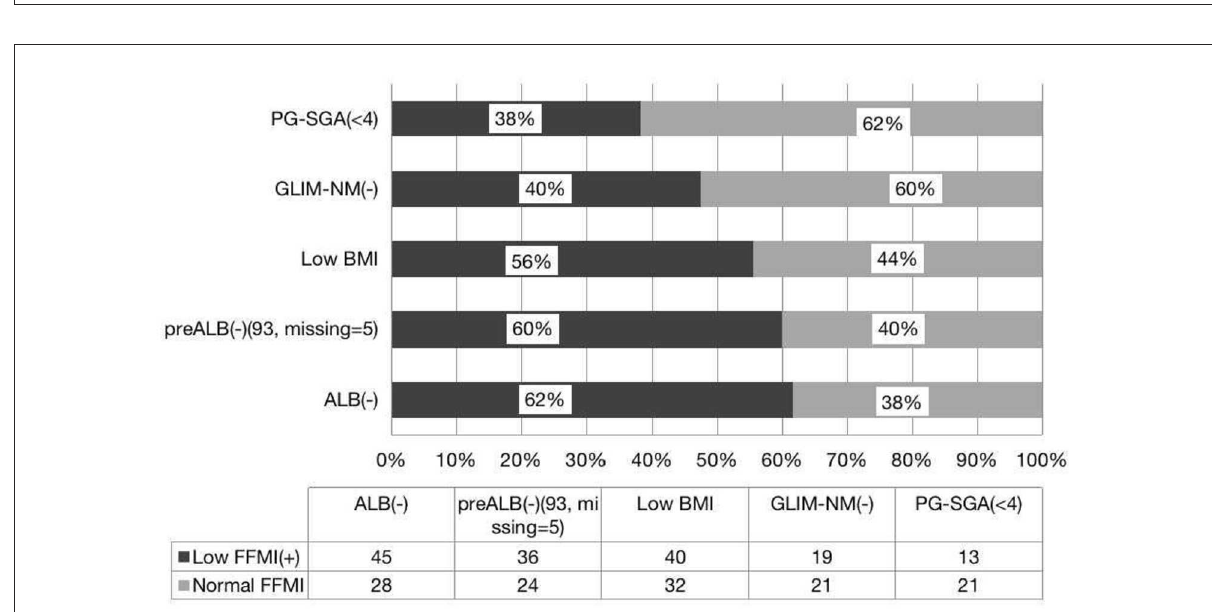
FIGURE2 Consistence of the FFMI with the nutritional scales/parameters in the nutritional assessment of patients with HSCT.